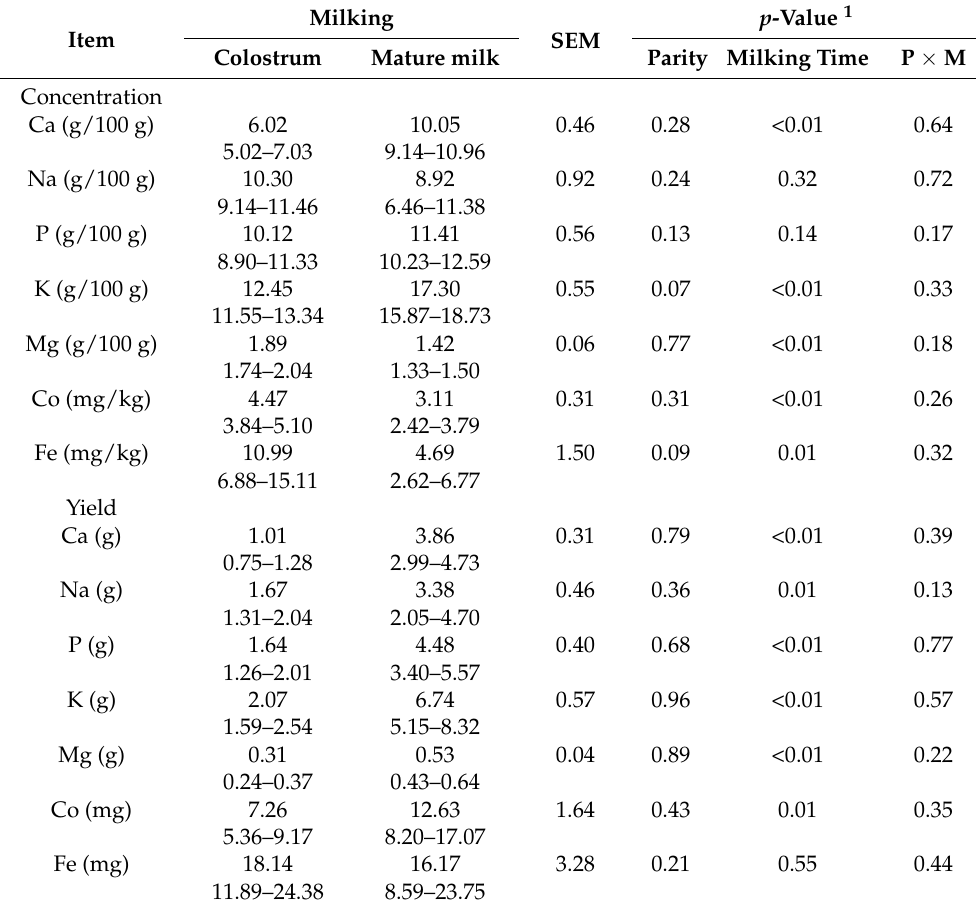
Table 6. Least squares means and 95% CI for mineral concentrations and yields in colostrum and mature milk mineral with different parities and milking time (n =